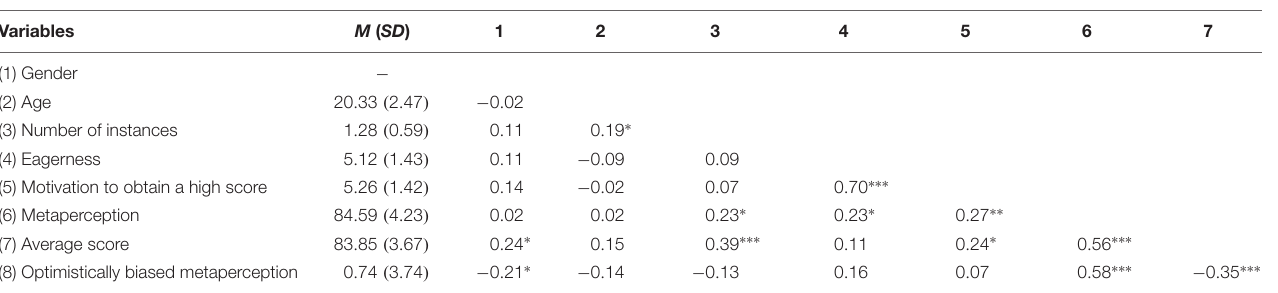
TABLE 1 | Descriptive statistics and correlation matrix among variables (Study 1).